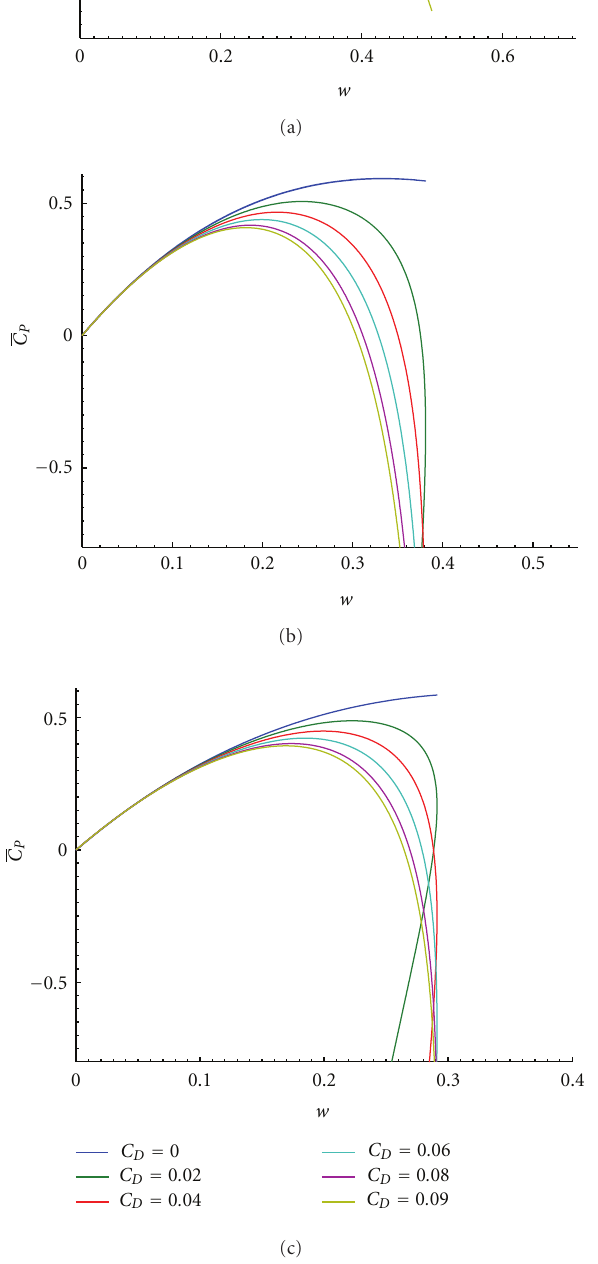
Figure 5: (a) C P versus w for θ = 0 ◦ , (b) C P versus w for θ = 2 ◦ , and (c) C P versus w for θ = 3 ◦ .